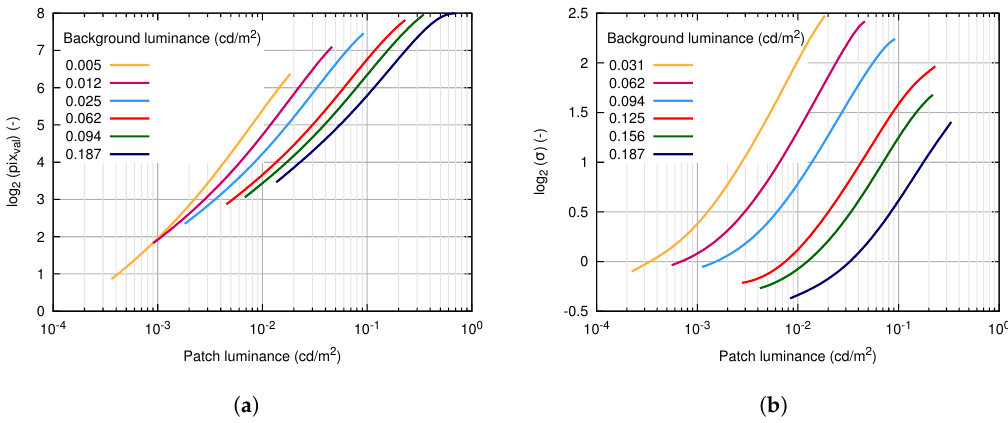
Figure 5. Image intensifier characteristics. ( a ) Opto-electronic conversion function dependence of the digital level in the output image on patch brightness for various background luminances. ( b ) Noise standard deviation dependence on patch brightness for various background luminances (gain levels of image intensifier). cd/m 2 : candela per square meter.